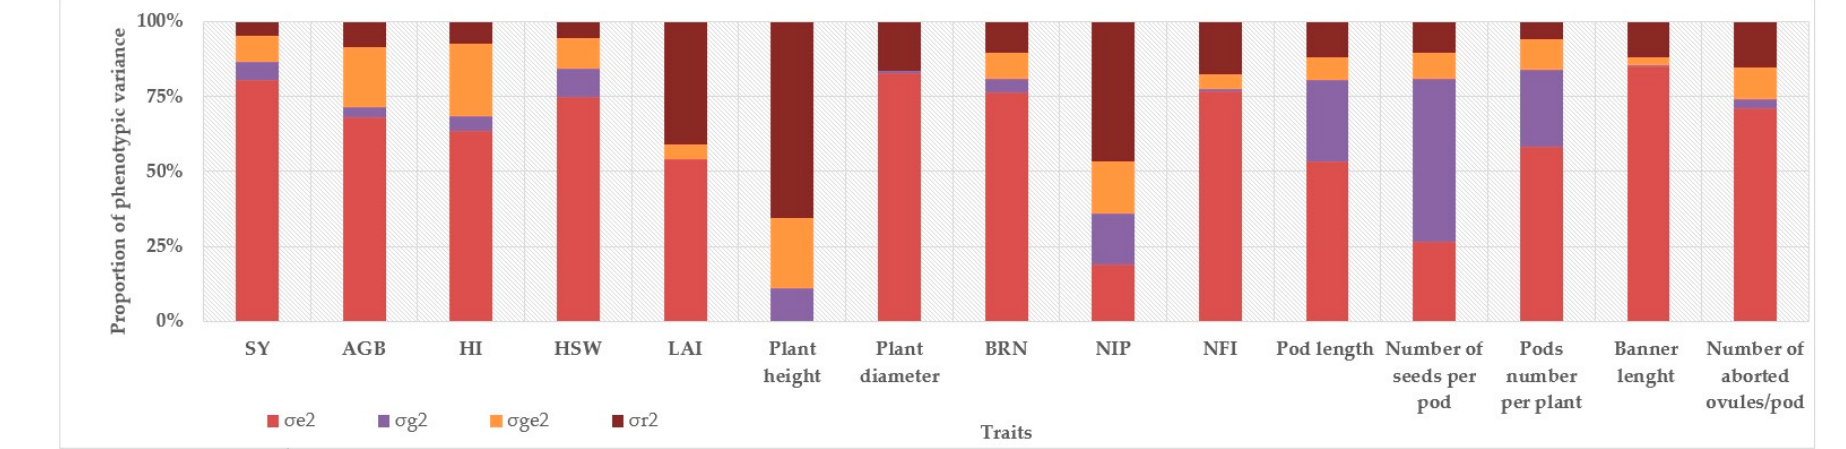
Figure 2. Proportion of the phenotypic variance for fifteen faba bean traits (SY, AGB, HI, HSW, LAI; plant height, plant diameter, BRN, NBBF, pod length, seed number per pod, pods number per plant, banner length, and aborted fruits number per pod) evaluated during three consecutive growing seasons. SY = seed yield; AGB = above ground biomass; HI = harvest index; HSW = 100 seed weight; LAI = leaf area index; BRN = branch number; NIP = number of inflorescences per plant; NFI = number of flowers per inflorescence. σ e2 = environment variance; σ g2 = genotype variance; σ ge2 = interaction g × e variance, and σ r2 = residual variance.